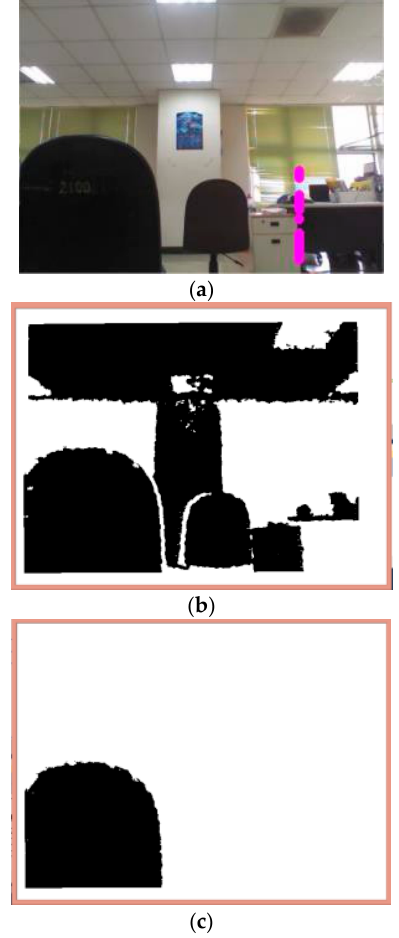
Figure 4. ( a ) Camera image, ( b ) depth map, ( c ) depth map threshold of 1.5